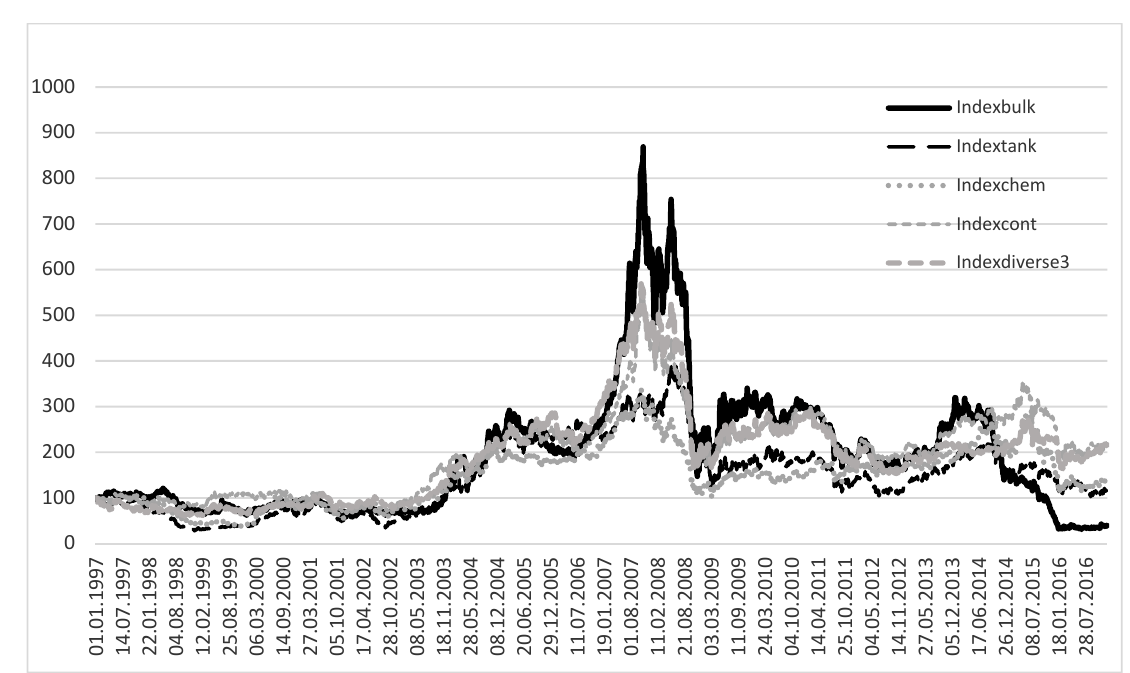
Figure 1. Shipping market segments index values. Note: IndexBulk = A level index created from the returns for the bulk segment, starting at 100; IndexTank = A level index created from the returns for the tanker segment, starting at 100; IndexChem = A level index created from the returns for the chemical/gas segment, starting at 100; IndexBulk = A level index created from the returns for the bulk segment, starting at 100; IndexContainer = A level index created from the returns for the container segment, starting at 100; IndexDiverse = A level index created from the returns for the diverse segment, starting at 100; IndexMarket = A level index created from the global market returns.